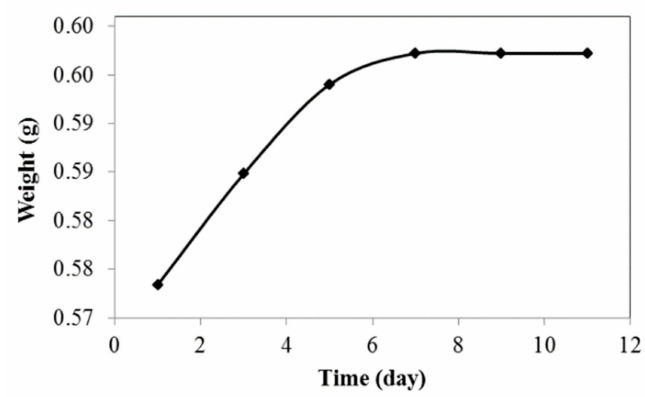
Figure 9. Water absorption of